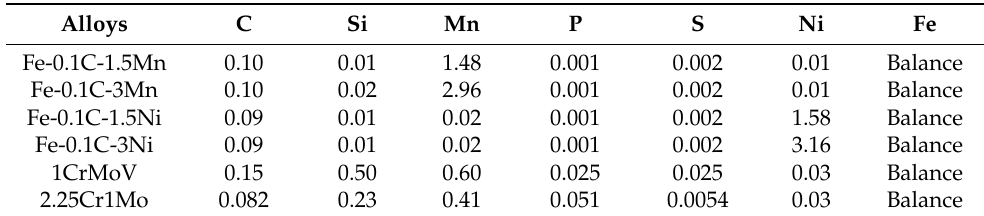
Table 4. Chemical composition of different grades of low alloy steels, reprinted with permission from refs. [41,42]. Copyright 2015 Elsevier